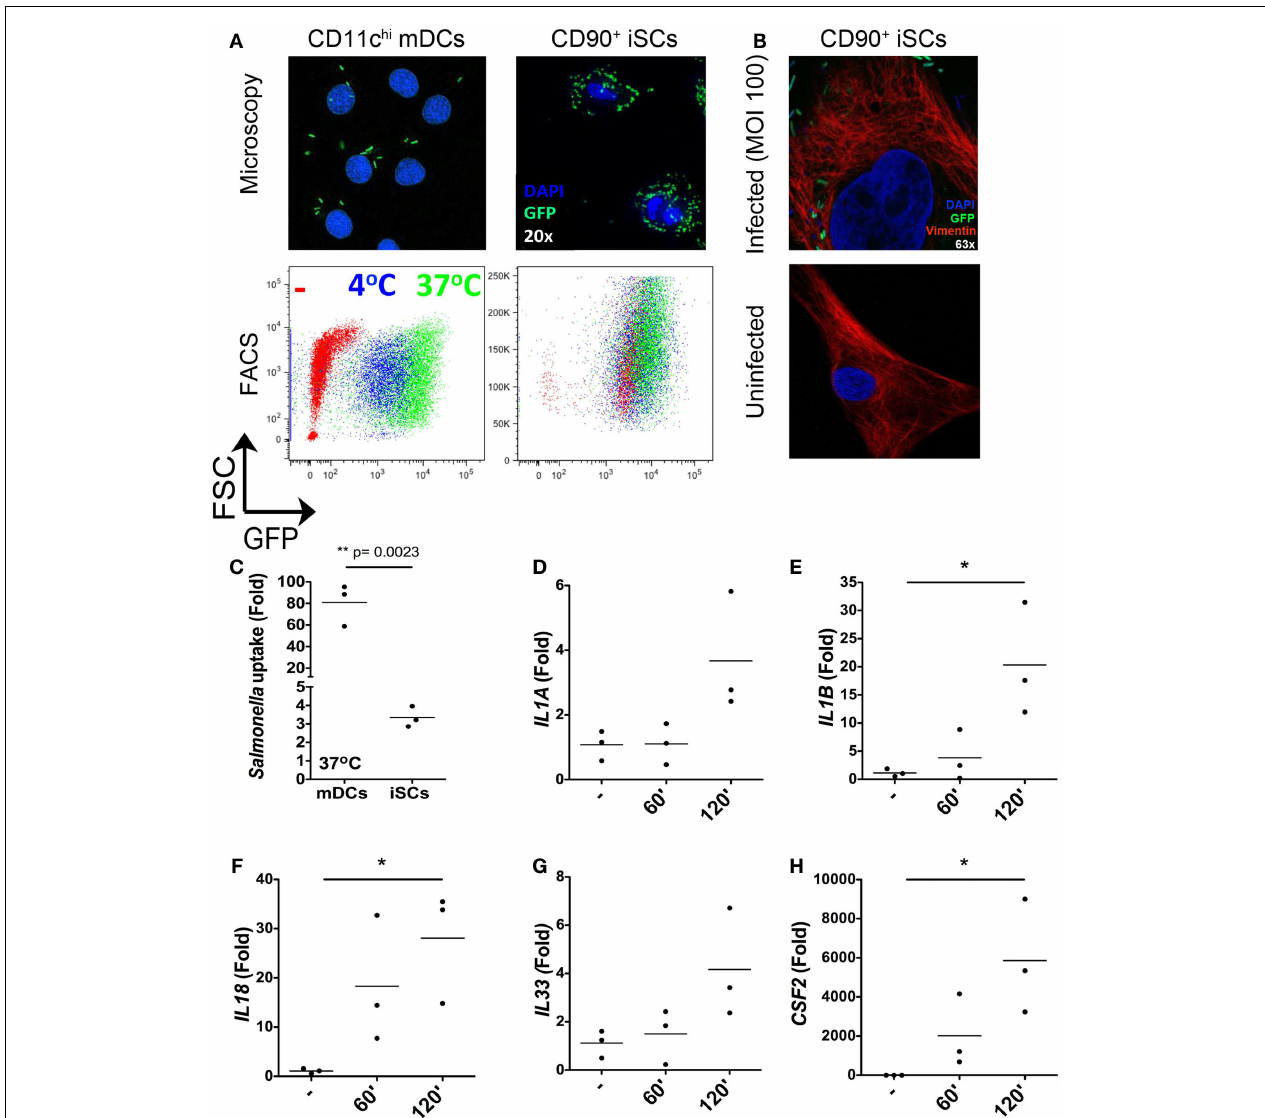
change in GFP MFI determined by flow cytometry. (D–H) Show the mean fold increases in expression of the indicated genes after exposure of iSCs to Salmonella at an MOI of 10 for the indicated time periods, relative to unstimulated cells. (A,B) shows representative images and FACS plots, data in (C) quantified from mDCs generated from peripheral blood of n = 3 healthy donors, compared to iSCs from colonic tissue of n = 3 surgical patients. Data in (D–H) are from iSCs isolated from colonic tissue of n = 3 patients. * p < 0.05, other p values as